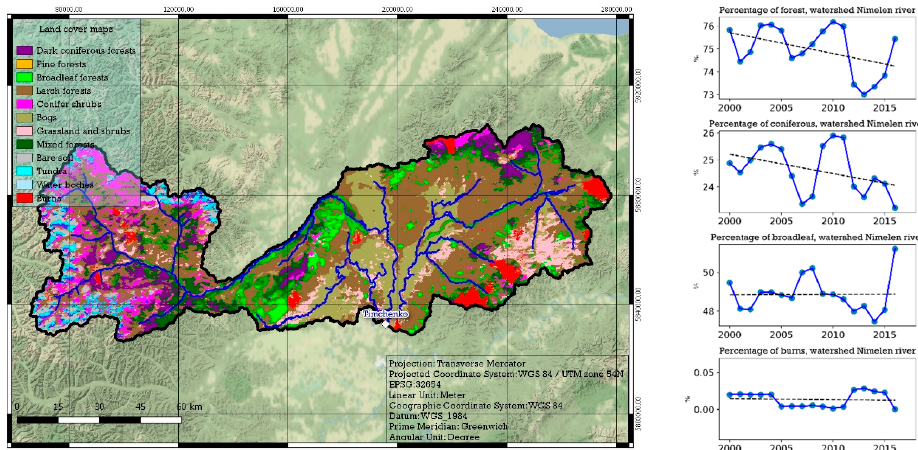
Figure A3. Vegetation dynamics of Nimelen River watershed. Stream gaging is marked with the Figure 14. Vegetation dynamics of Nimelen River watershed. Stream gaging is marked with the white Geosciences 2019 , 9 , x FOR PEER REVIEW white diamond. Figure 14. Vegetation dynamics of Nimelen River watershed. Stream gaging is marked with the white diamond. diamond.